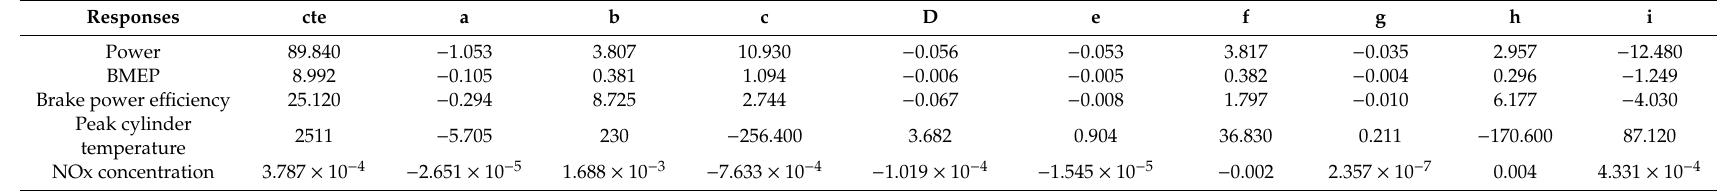
Table 4. The Equation (6) constant parameters and